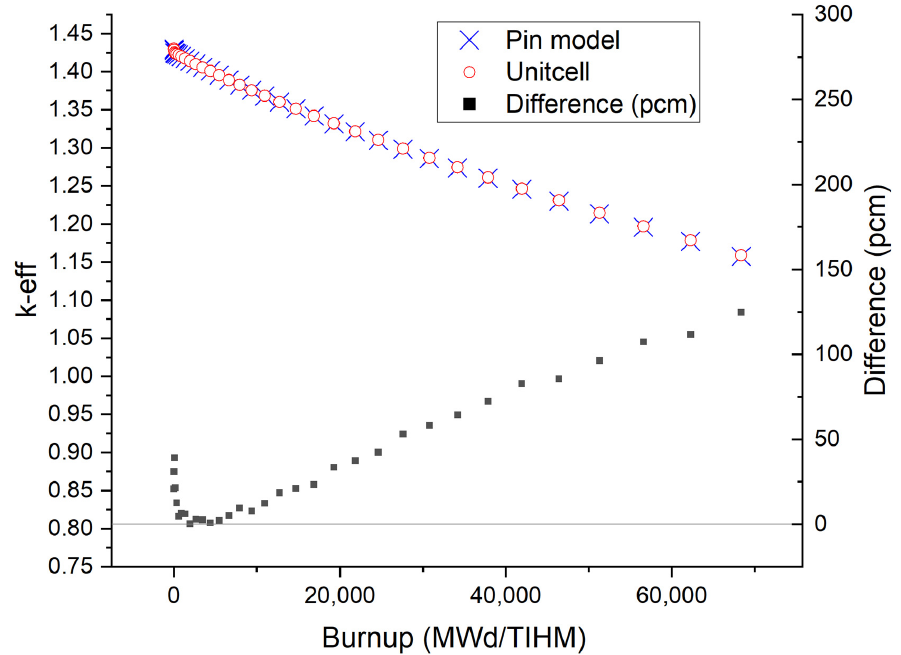
Figure 7. Difference in k-eff, the effective neutron multiplication in the model, between the axial RPT model of the pin and the radial unit cell model across a standard burnup cycle. As the pin reached